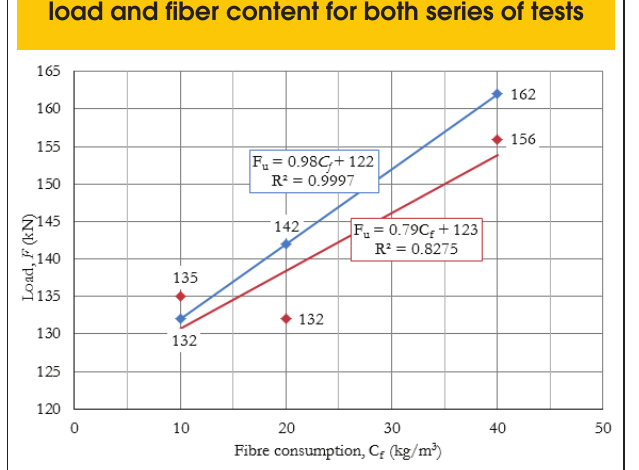
Figure 18 – Correlations between ultimate load and fiber content for both series of tests